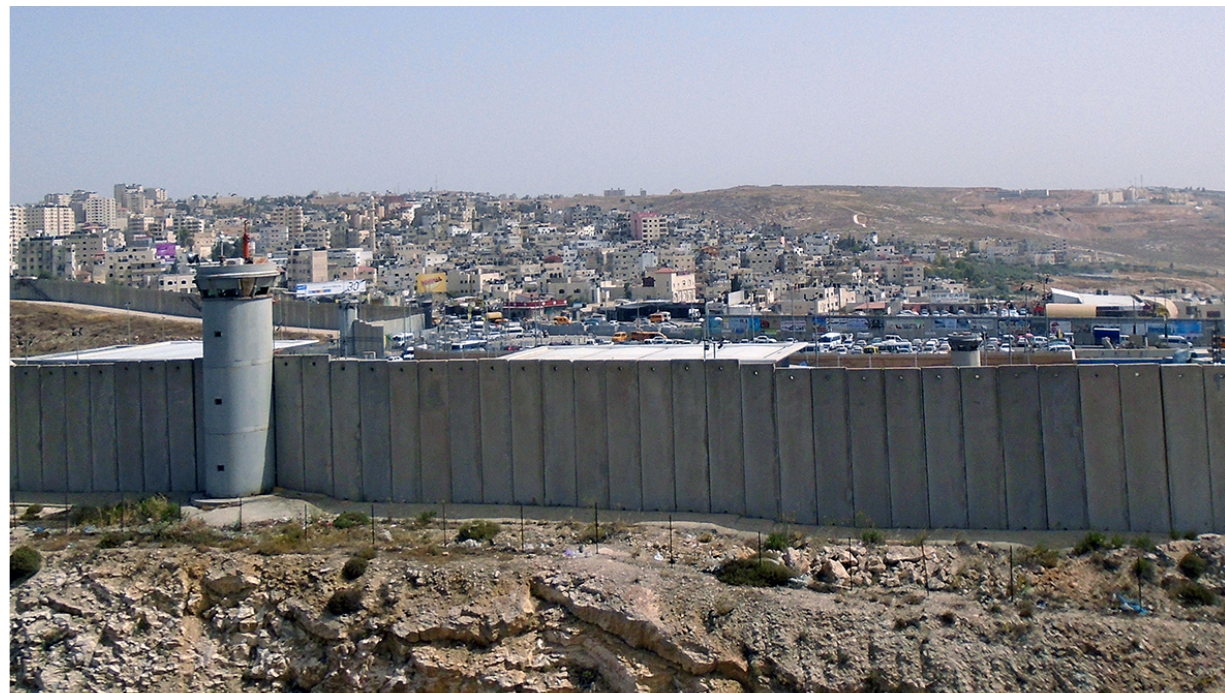
Figure 8. Separation Wall in the West